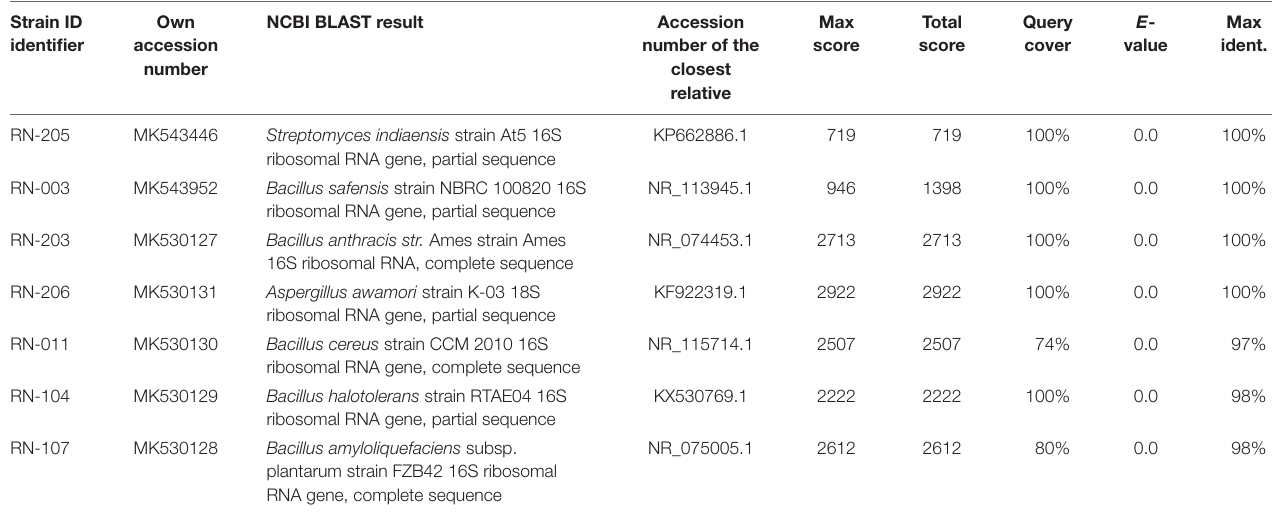
TABLE 1 | Results for DNA sequencing using NCBI GenBank